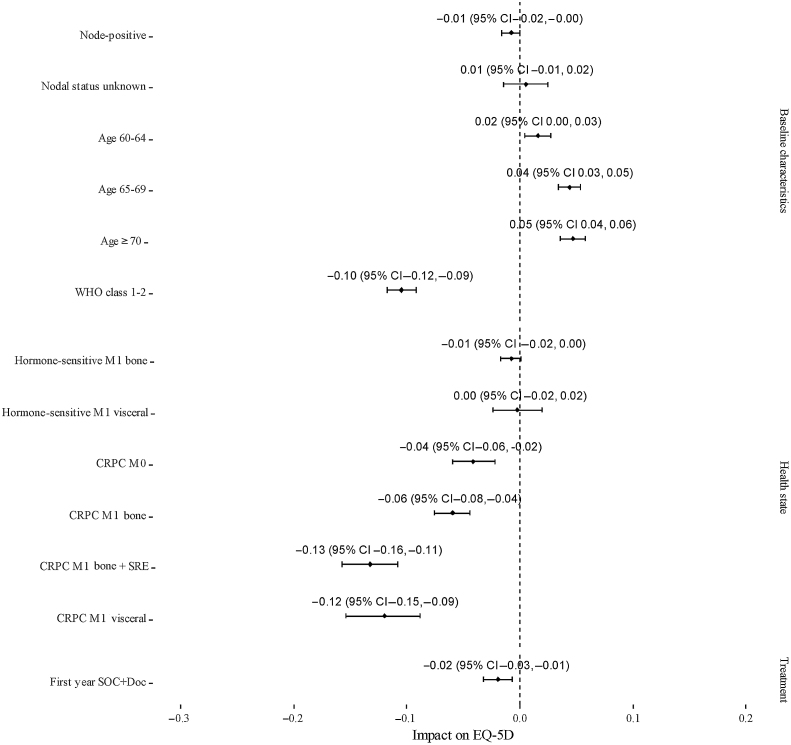
Impact of baseline characteristics, health state, and treatment allocation on patient health-related quality of life (HRQOL) in STAMPEDE. This graph presents the results of an analysis of EQ-5D data obtained from STAMPEDE adjusted for baseline characteristics, treatment allocation, and current health state. Data were collected at baseline and at follow-up visits: every 6 wk for the first 6 mo, then every 12 wk up to 2 yr, every 6 mo up to 5 yr, and annually thereafter. The impact of each covariate on HRQOL is shown relative to a reference patient with nonmetastatic disease, World Health Organisation class 0, age ≤60 yr, and node-negative in their first year of standard of care. Positive values indicate better and negative values indicate worse HRQOL relative to the reference patient. CRPC = castrate-resistant prostate cancer; SRE = skeletal-related event, M0 = nonmetastatic, M1 = metastatic.